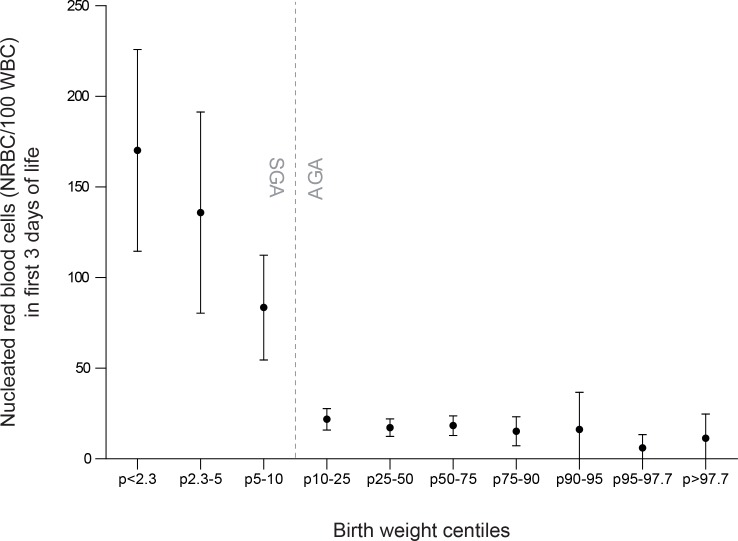
Relationship between nucleated red blood cells in the first 3 days of life and birth weight centiles.Boxplot representing observed nucleated red blood cells (NRBC/100 white blood cells) in all included neonates (SGA and AGA, N = 653) in the first 3 days of life, categorized by birth weight centiles. Boxplot shows mean (black dots) and 95% confidence intervals (whiskers). Five missing values in SGA group, 2 in AGA group.